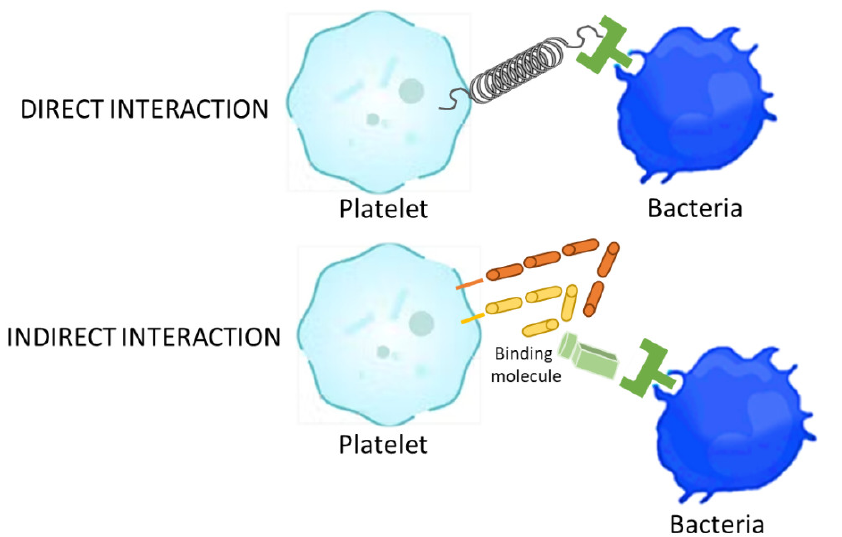
Figure 2. General mechanisms of platelets bacterial interaction (direct and indirect). Adapted from Fogagnolo et al. [36] by GIMP 2.10.32 software.